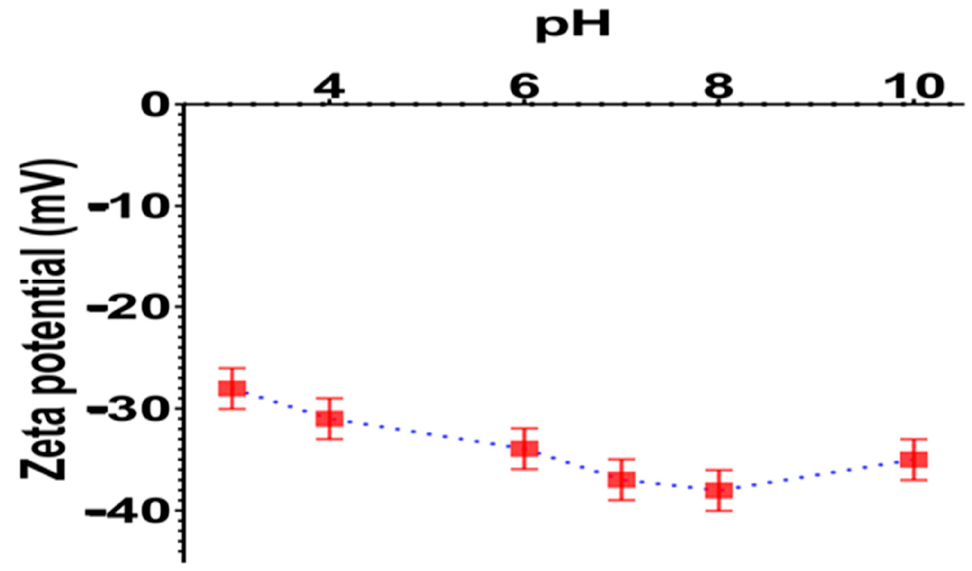
Figure 3 . The zeta potential of P(St/AA) particles as a function of pH at 20 °C. Figure 3. The zeta potential of P(St/AA) particles as a function of pH at 20 ◦